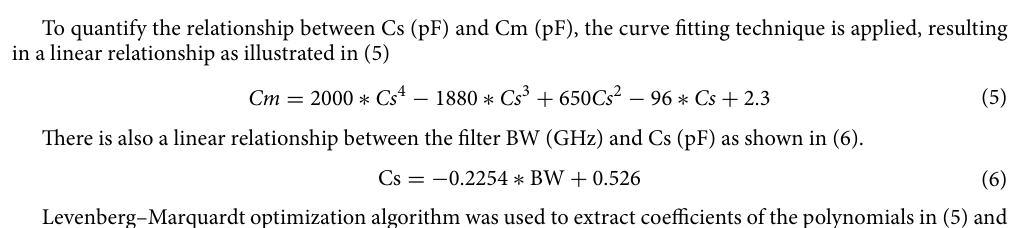
Figure 13. ( a ) Fabricated prototype tunable BPF and ( b ) Simulation results and measurement